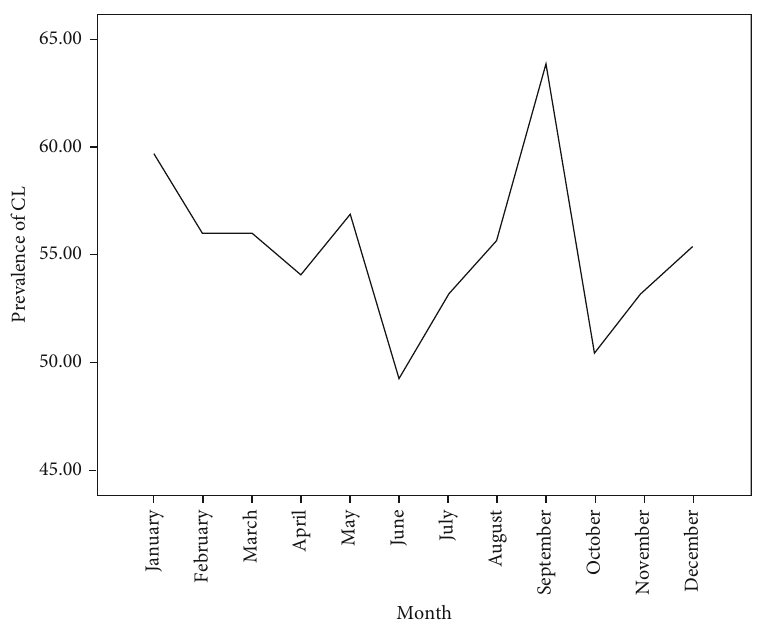
Figure 2: The aggregate monthly prevalence rate of CL cases at LRTC, University of Gondar, Ethiopia, 2009-2018.